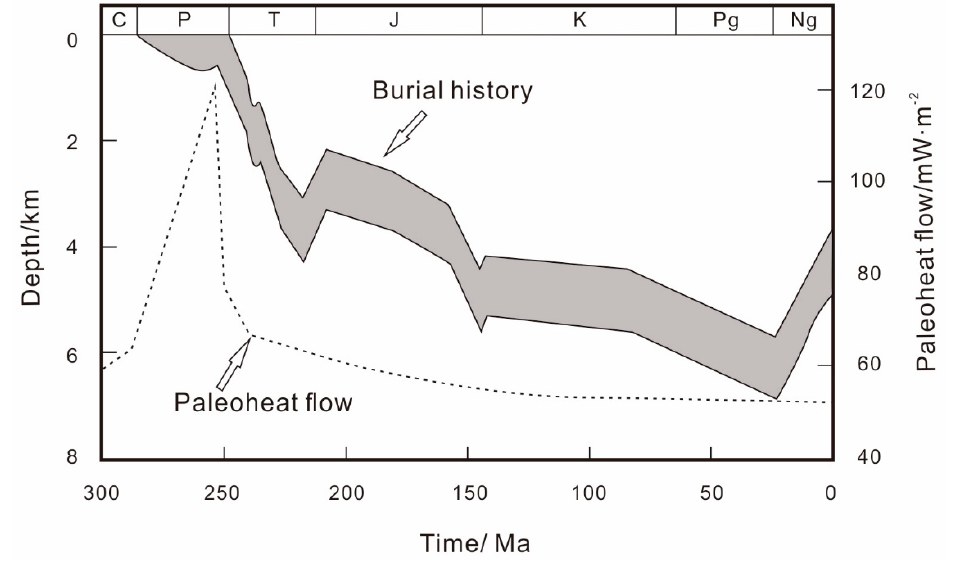
Figure 2. The synthetic map of burial history–paleoheat flow distribution of Well Hanshen1 in the southwest Sichuan Basin [31–33].